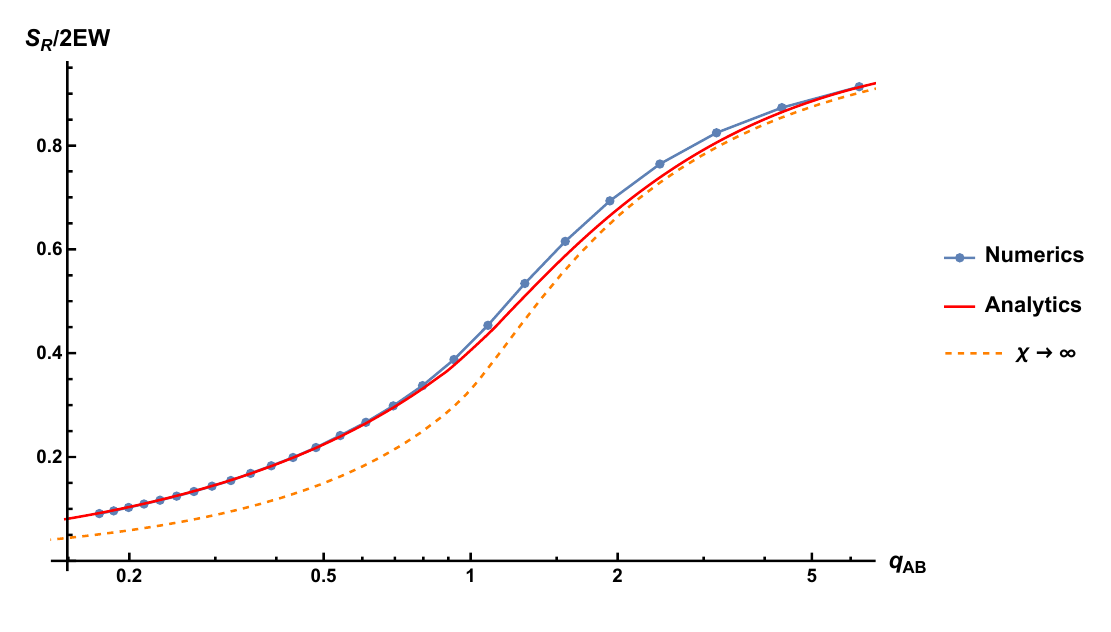
Figure 20 . Plots of the reflected entropy, normalized by twice the EW cross-section 2 ln χ . The analytic prediction (red) is obtained by summing over the eigenvalues in k = 0 , 1 , 2 sectors (these are the only available ones due to the rank constraint), including the first order corrections and the contribution from spreading (eq. (4.72)). We have also included the form of S shown as the orange dashed line for